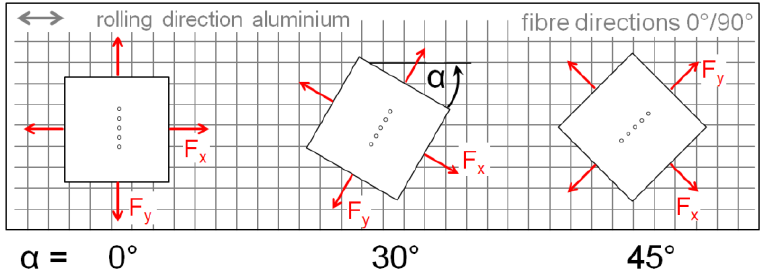
Figure 2. Biaxial specimen design and pattern of blunt notches.